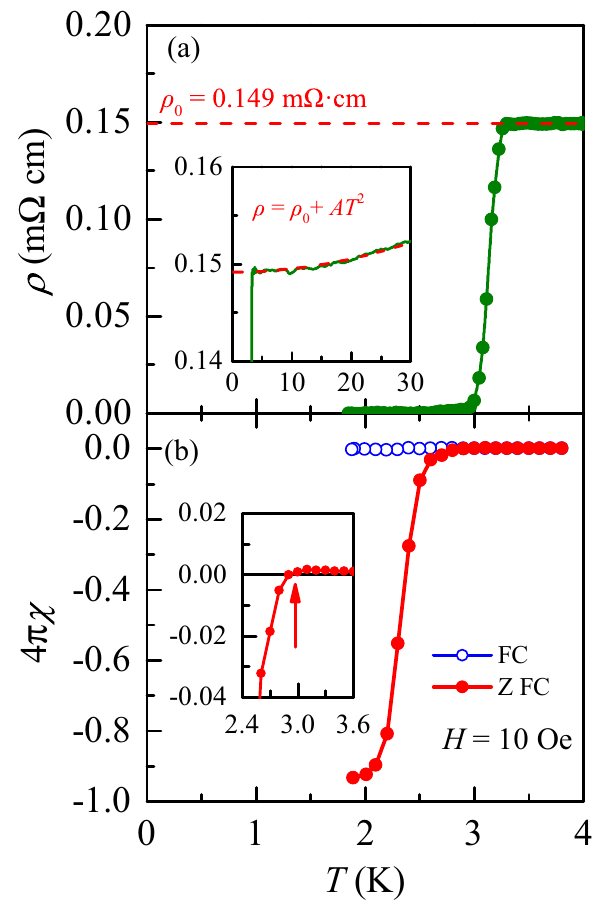
AT 2 , from which ρ ρ 0 0 is estimated as = +